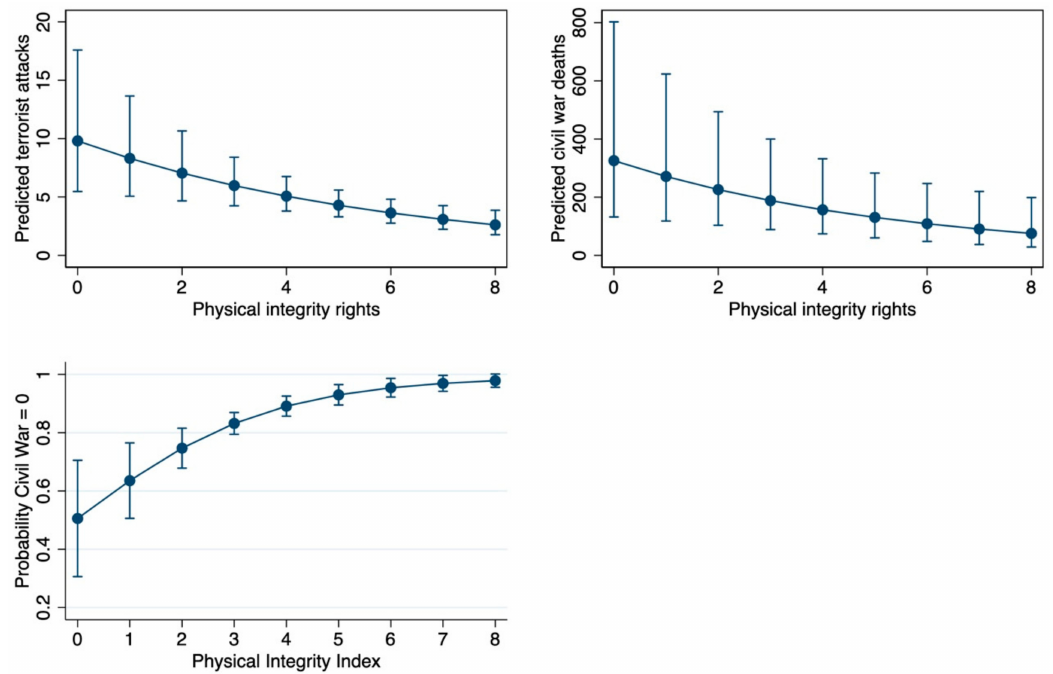
Figure 2. Physical integrity rights and conflict 95%